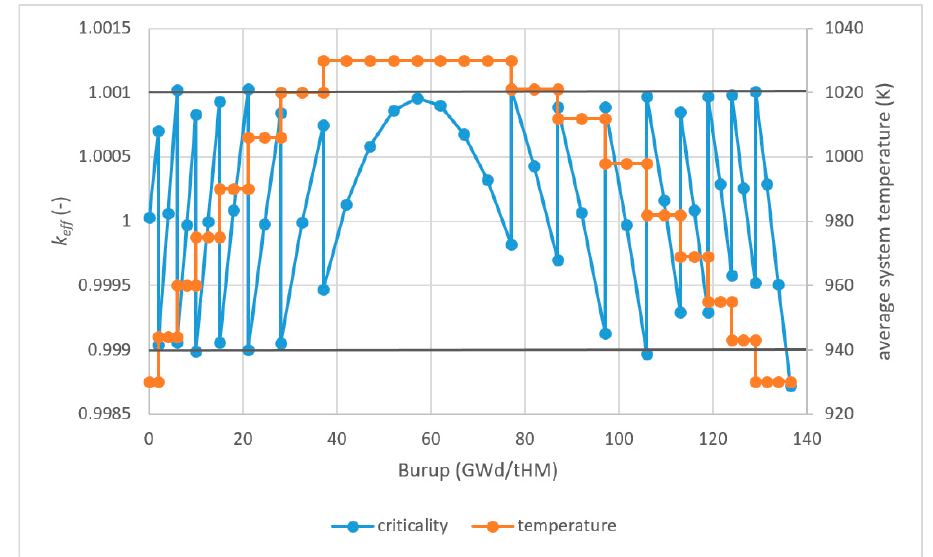
Figure 10. Criticality over burnup for the temperature varied system with the criticality given on the left axis and the system averaged temperature on the right axis for the heavy metal rich system .